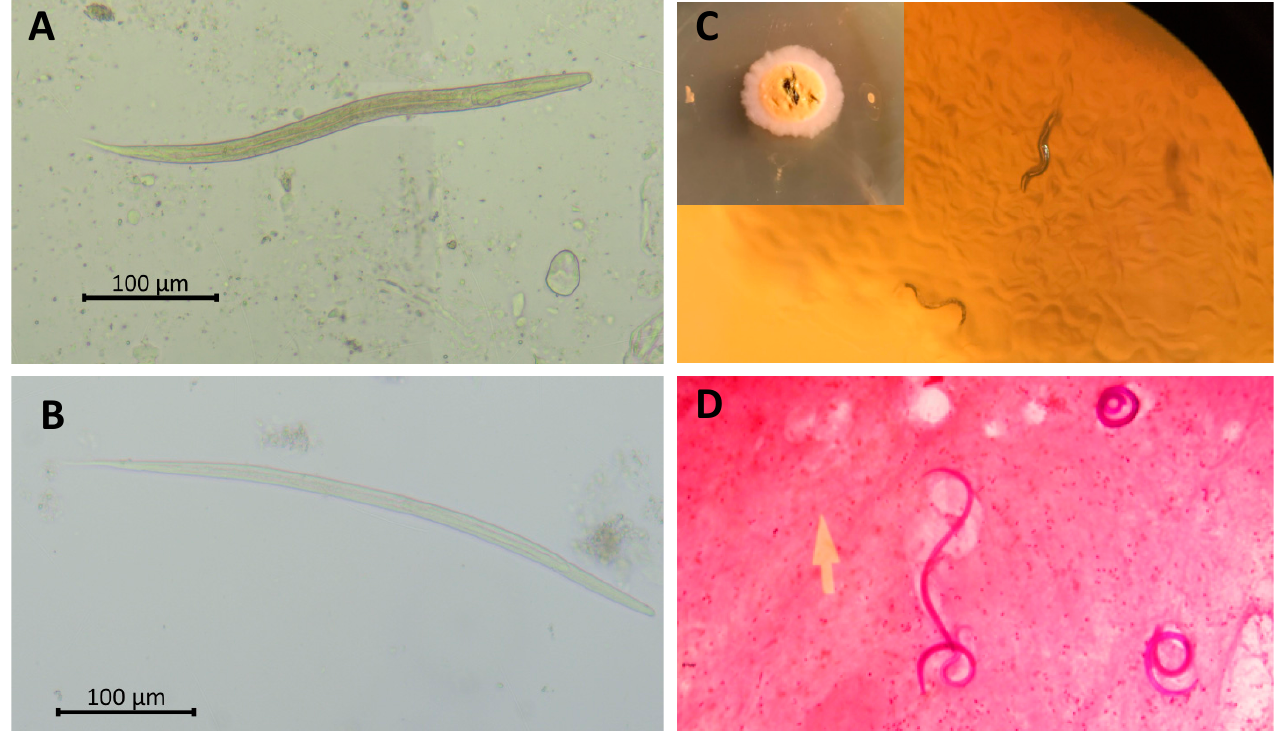
Figure 2. Parasitological detection of Strongyloides stercoralis. Rhabditiform ( A ) and filariform; ( B ) larvae of S. stercoralis fresh smear. Migrating rhabditiform larvae in agar plate culture; ( C ). Gram staining of filariform larvae in sputum of a patient with S. stercoralis hyperinfection syndrome (100×) ( D ) Picture; ( C ) courtesy of Poom Adisakwattana.